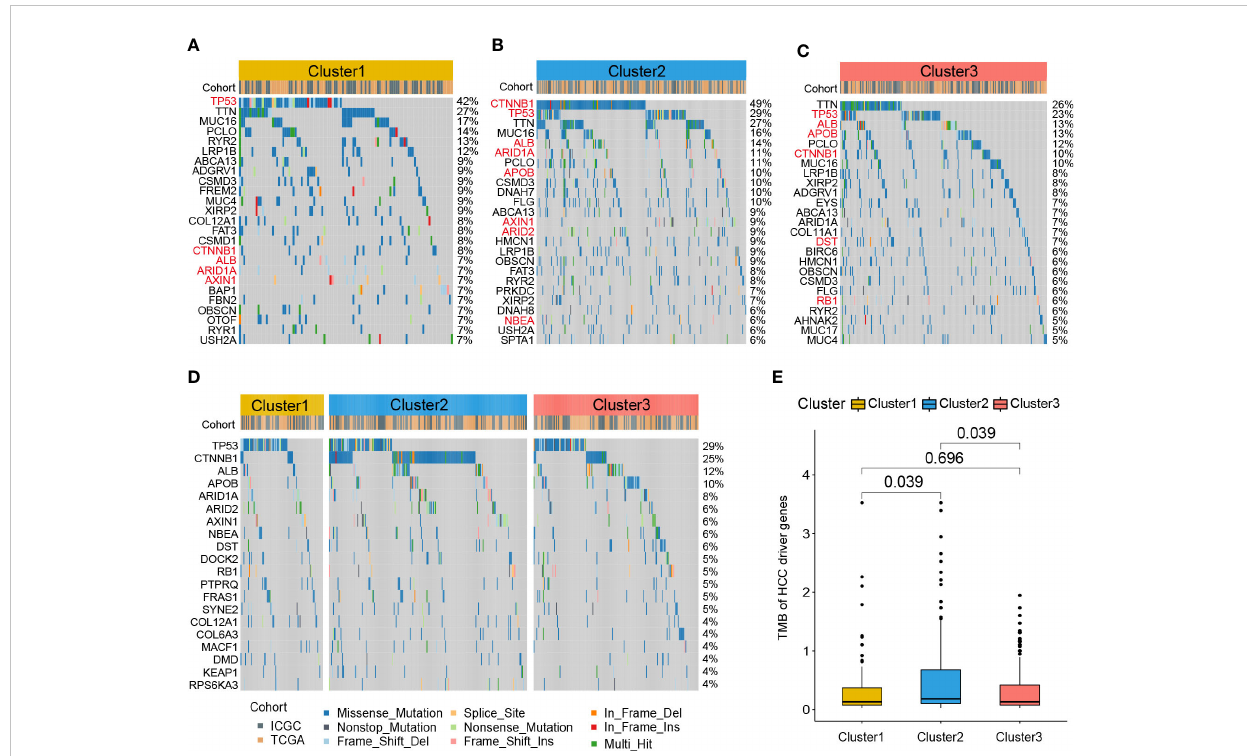
FIGURE 6 Gene mutation pro fi le of zonation marker associated HCC clusters. Oncoplots of the top 25 somatic mutation genes in Cluster1 (A) , Cluster2 (B) , and Cluster3 (C) . Red represents HCC driver genes. Oncoplot of the top 20 somatic mutations of HCC driver genes (D) . Difference of TMB of HCC driver genes among the three clusters by Kruskal – Wallis test (E) . TMB, Tumor mutation